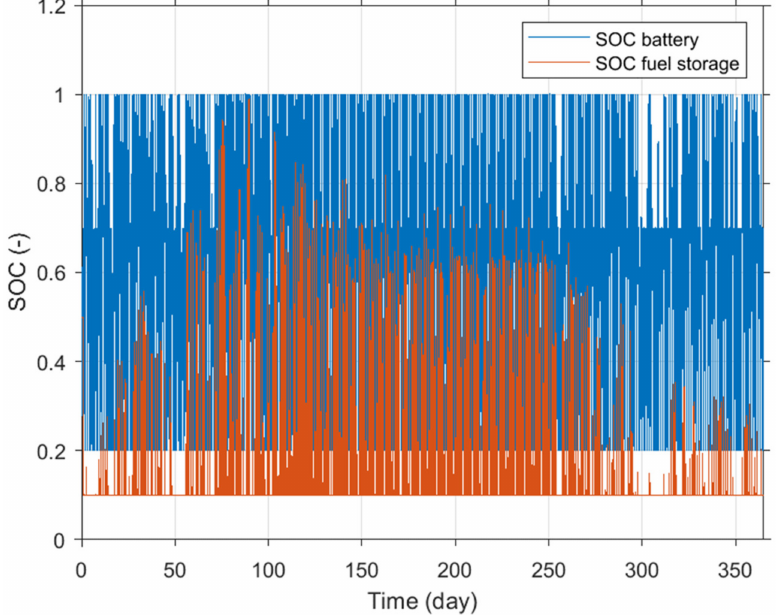
Figure 10. The seasonal behavior of the battery and the fuel storage in an annual basis starting from January in the Scenario